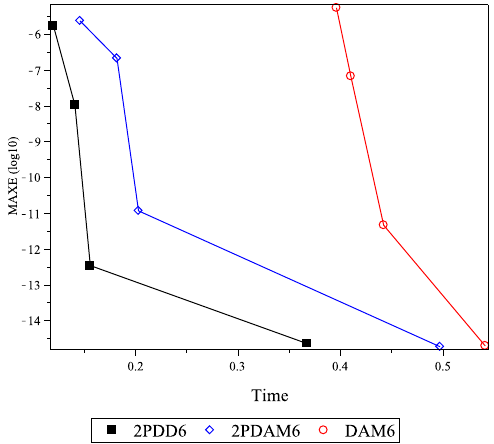
Figure 5. Performance graphs of time vs. log MAXE for Problem